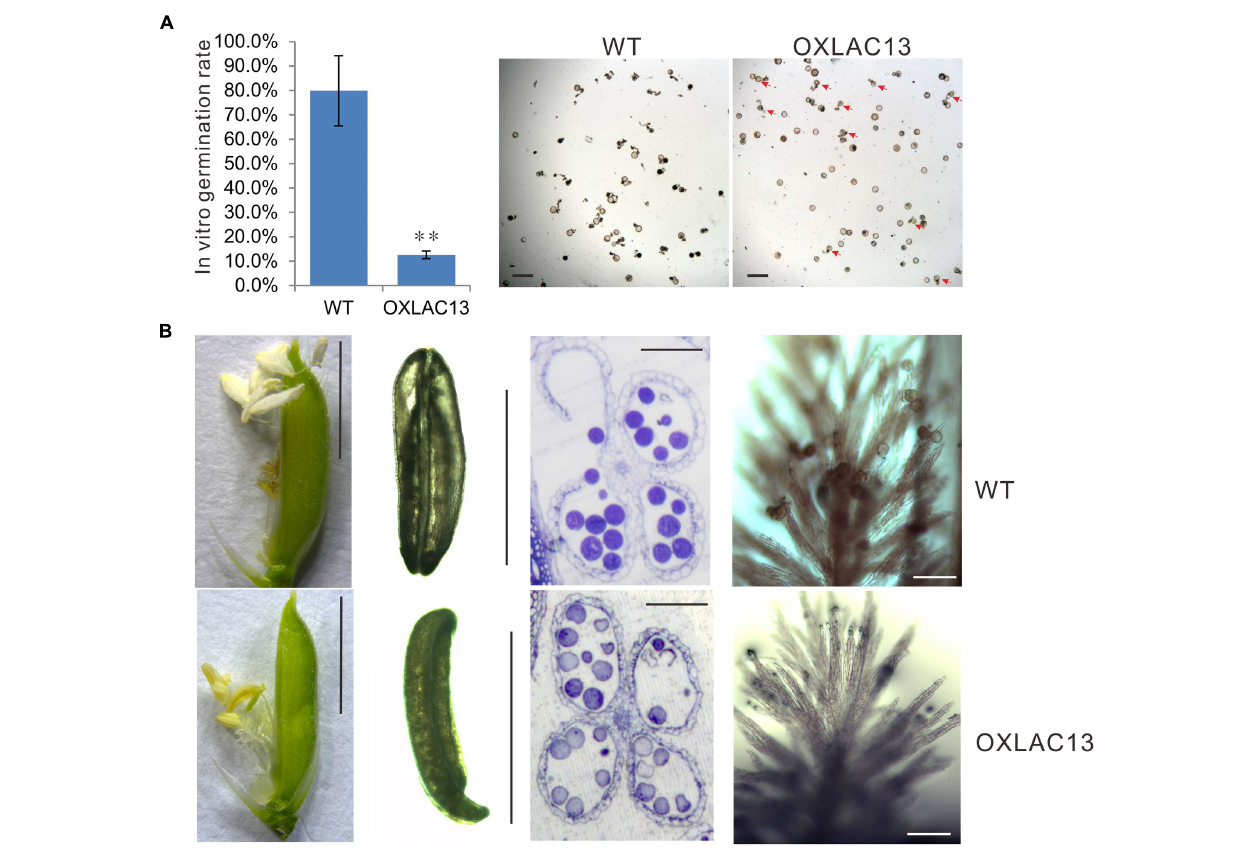
FIGURE 2 | Defects of OXLAC13 plants in late anther development. (A) In vitro germination rates of WT and OXLAC13 pollen. Scale bars, 100 µ m. Values are means ± s. d. ( n = 200 pollen grains). Red arrows indicate the succesfully germinated OXLAC13 pollen grains. Significant differences were identified at the 5% ( ∗ ) and 1% ( ∗∗ ) probability levels using Student’s t -test. (B) Spikelets 1 day after flowering (Scale bars, 4 mm), anthers after flowering (Scale bars, 2 mm), transverse sections of anthers after flowering (Scale bars, 100 µ m) and the stigmas 2 h after flowering (Scale bars, 100 µ m) of WT and OXLAC13 plants from the left panels to the right